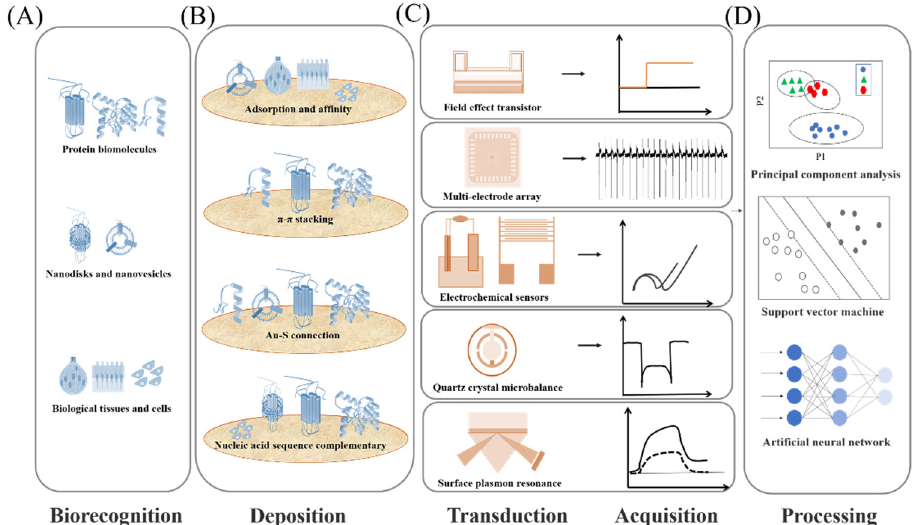
Figure 1. Scheme of main components construction of different detection strategies development for olfactory and gustatory recognition. ( A ) Biorecognition parts for the sensing of olfactory and gustatory ligands. ( B ) Effective deposition methods of sensitive materials on transducers surface. ( C ) Various transduction techniques to sense the responsive signals. ( D ) Signal processing and pattern recognition methods.